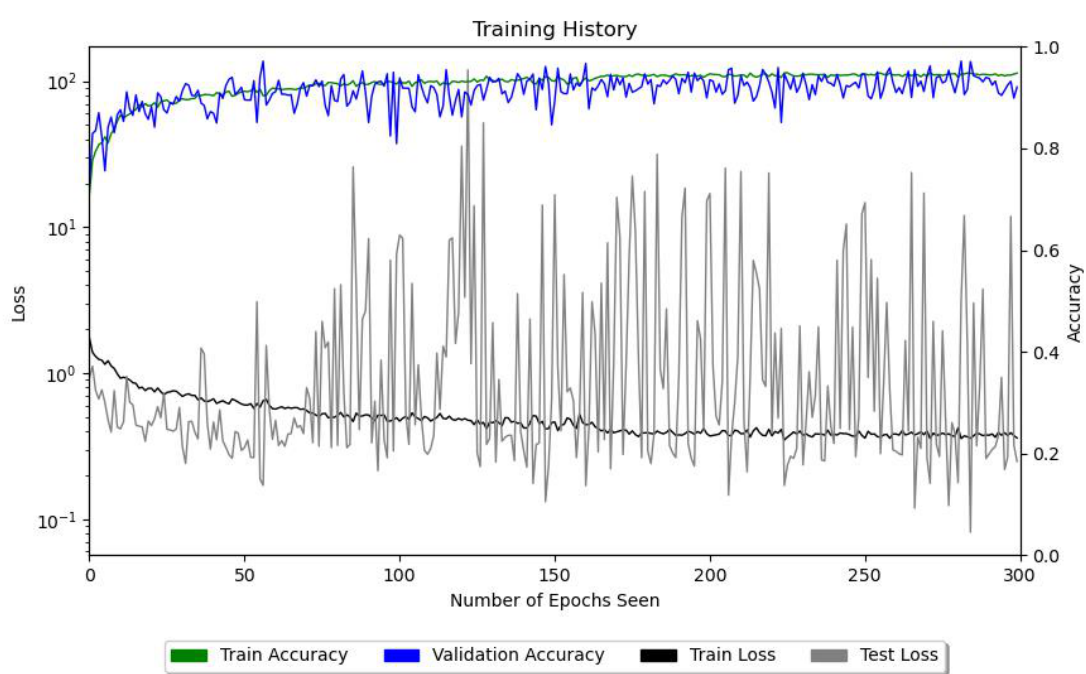
Figure A1. This figure presents the training history of our model, showing the overall training and validation accuracies and their losses over the 300 epochs of training.